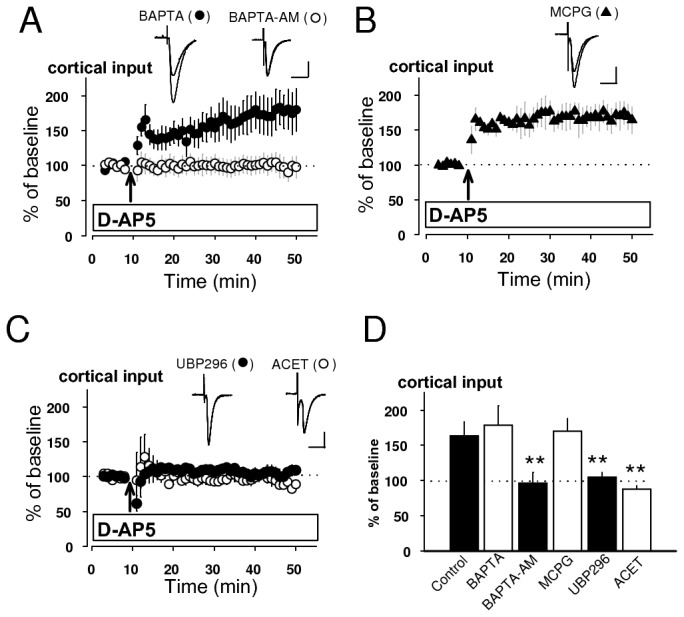
LTP in cortical input also depends on presynaptic KAR.
A-C, Graphs summarizing LTP experiments showing the effect of Ca2+ chelators (A: BAPTA, BAPTA-AM), metabotropic glutamate receptor antagonist (B: MCPG) and selective KAR antagonists (C: UBP296, ACET) on the induction of LTP in cortical input. The respective insets show superimposition of averaged EPSCs recorded before and after the induction in the presence of each drug. Scale bars (A-C) 50 pA, 20 ms. D, Quantification of pharmacological analysis (A-C). Control was obtained from the result in Figure 1E. LTP in cortical input was blocked by BAPTA-AM (97 ± 15% of baseline, n=8, unpaired t test, p<0.01 versus control), but not by BAPTA (179 ± 27% of baseline, n=6, unpaired t test, p=0.53 versus control). This potetiation was resistant to MCPG (170 ± 18% of baseline, n=6, unpaired t test, p=0.68 versus control), but it was prevented by either UBP296 (105 ± 7% of baseline, n=5, unpaired t test, p<0.01 versus control) or ACET (88 ± 5% of baseline, n=5, unpaired t test, p<0.01 versus control). **p<0.01.